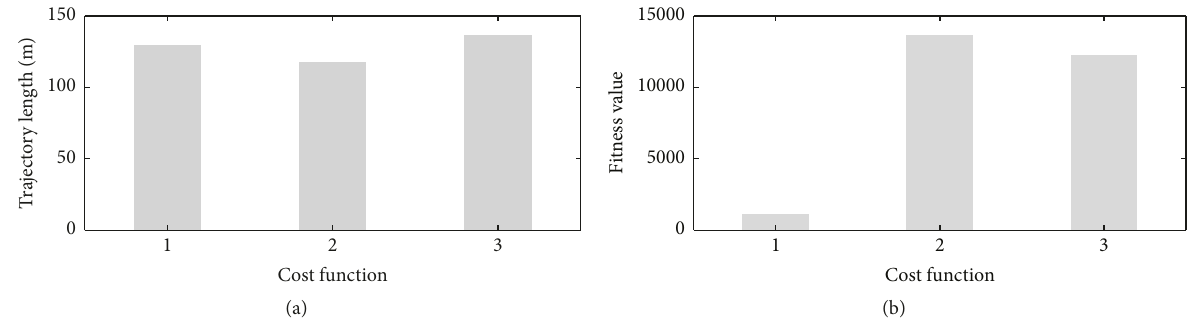
Figure 5: Performance criterion: (a) trajectory length and (b) fitness value,